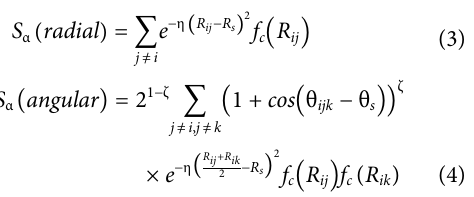
Frontiers in Chemistry |